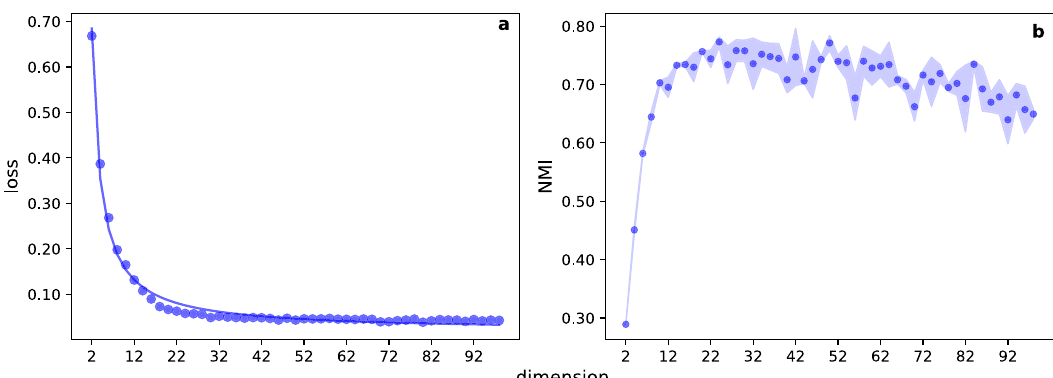
Fig. 2 Geometric embedding of synthetic networks. a Normalized loss as a function of the embedding dimension in SB networks. We generate graph instances composed of N = 256 nodes and C = 16 groups with p in = 0.2 and p out = 0.02. Embedding is performed using node2vec . The blue curve in panel a is the best fi t curve of Eq. (2) ( ^ s ¼ 1 : 323, ^ α ¼ 0 : 990, ^ L 1 ¼ 0 : 019 and R 2 = 5.93 × 10 − 3 ) with the data points. b Test of performance in recovering the ground-truth community structure in SB graphs as a function of the dimension of the embedding. We measure the recovery accuracy with normalized mutual information (NMI). Symbols refer to average values of NMI computed over 10 instances of the SB model; the shaded region identi fi es the range of values corresponding to one standard deviation away from the